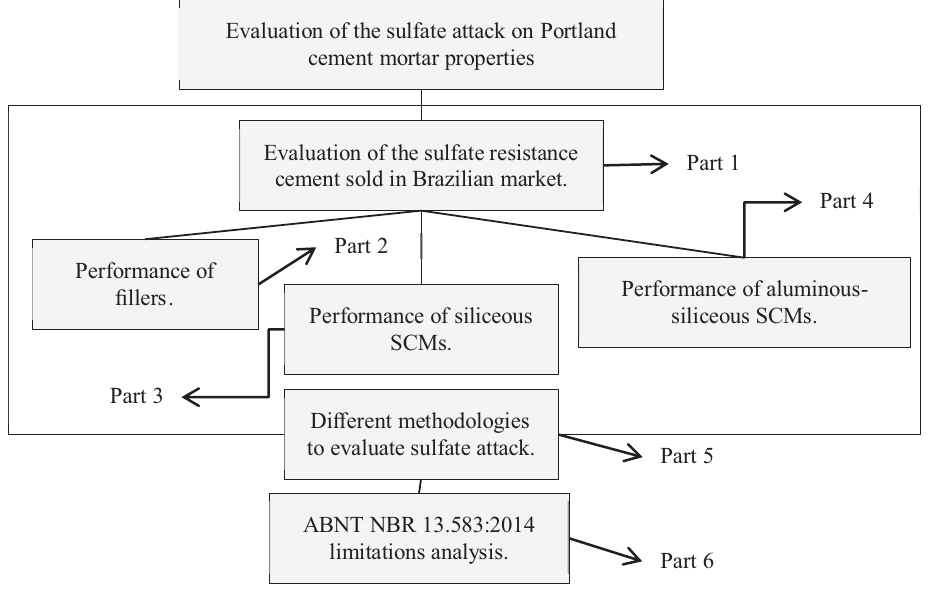
Division of the research project to evaluate sulfate attack on the properties of Portland cement mortars